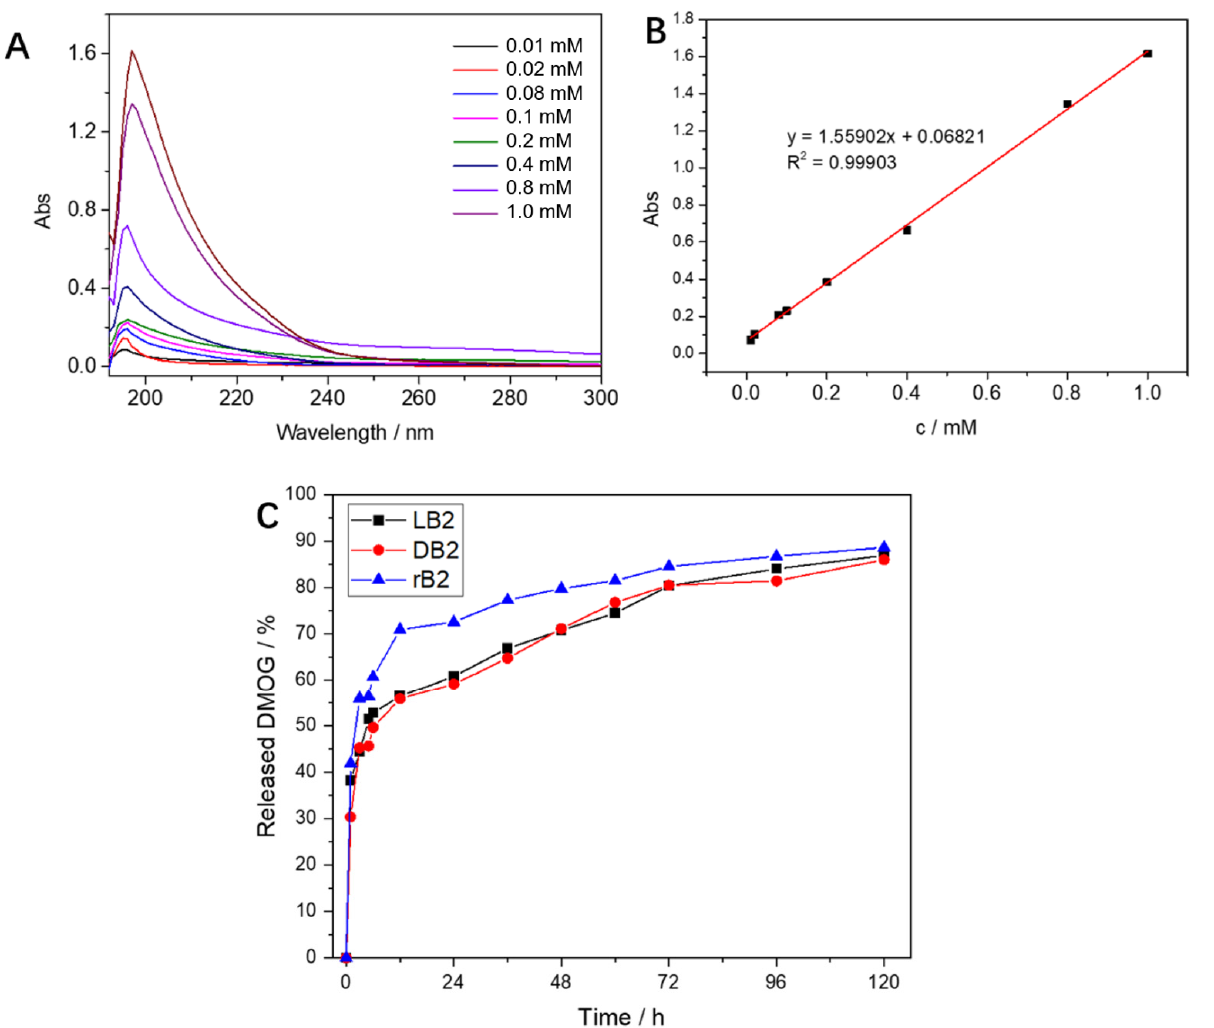
Figure 2. ( A ) The absorption curves of different concentrations of DMOG at the full wavelength, all have absorption peaks at 198 nm; ( B ) the regression-curve fitting of the DMOG concentration and the absorbance at a wavelength of 198 nm was performed, and it was found that the correlation coefficient R 2 = 0.99903, the correlation was good; ( C ) after mixing DMOG with the chiral hydrogels, the absorbance test was carried out at a 198 nm wavelength. The mixed-group hydrogel could release 70% in the first 12 h, while the left-handed and right-handed chiral hydrogels released slowly; after 120 h, almost complete release was observed.